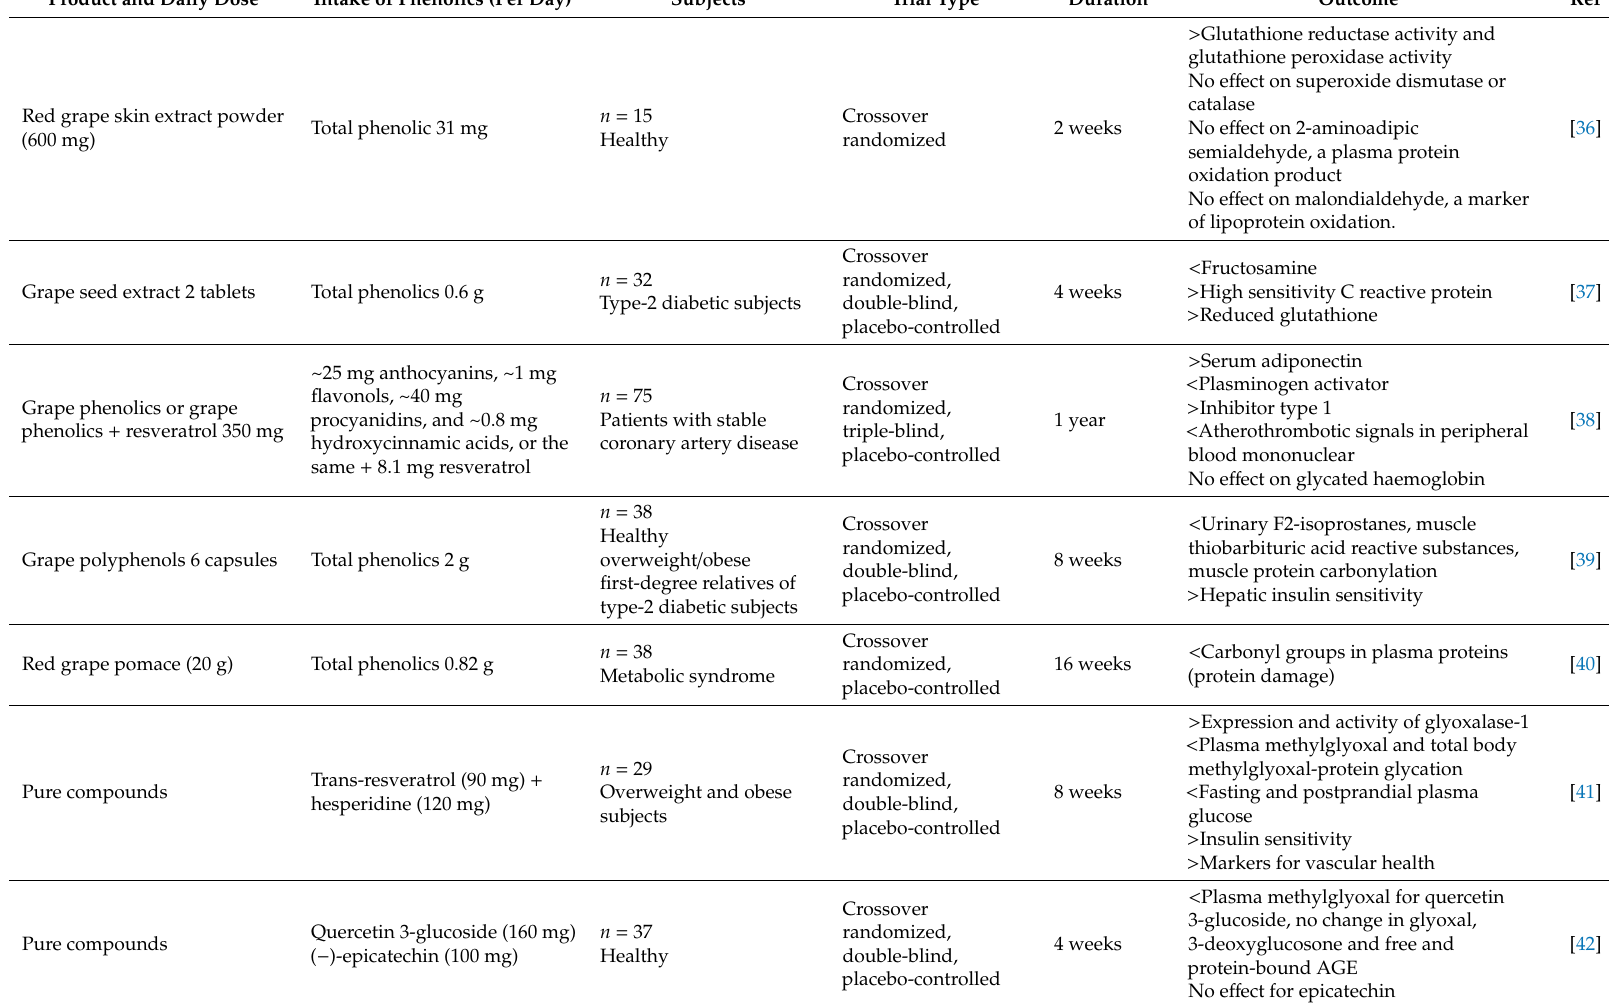
Table 1. In vivo studies on the inhibitory e ff ects of grape phenolics on protein